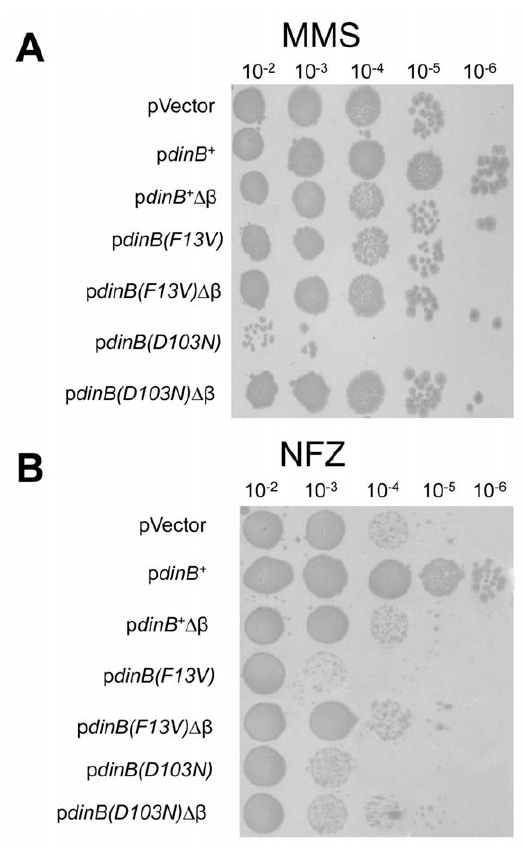
Figure 6. D dinB with variants lacking the residues comprising the b -clamp binding motif are no longer highly sensitive to MMS or NFZ. ( A ) A representative LB medium plate containing MMS (7.5 mM) with 10 fold serial dilutions of D dinB cells bearing the plasmid- borne dinB alleles is shown. ( B ) Same as ( A ) except cells were deposited on LB medium plates with NFZ (0.008 mM).